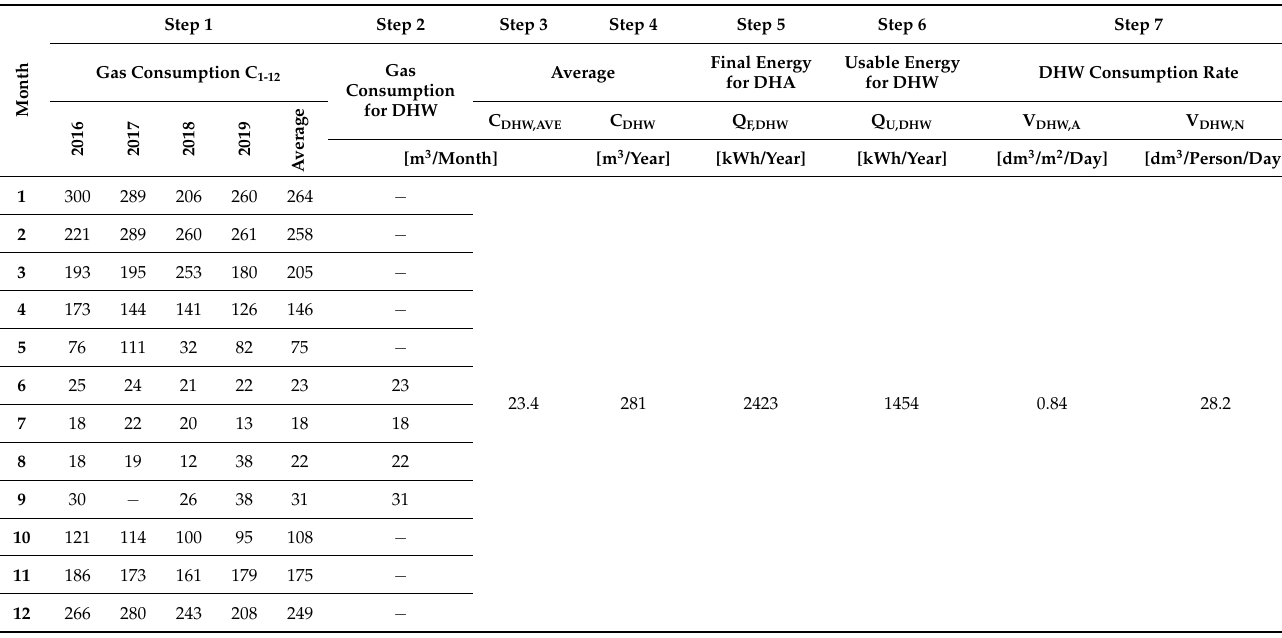
Table 4. Determination of DHW consumption indicators for building B2 (according to the diagram in Figure